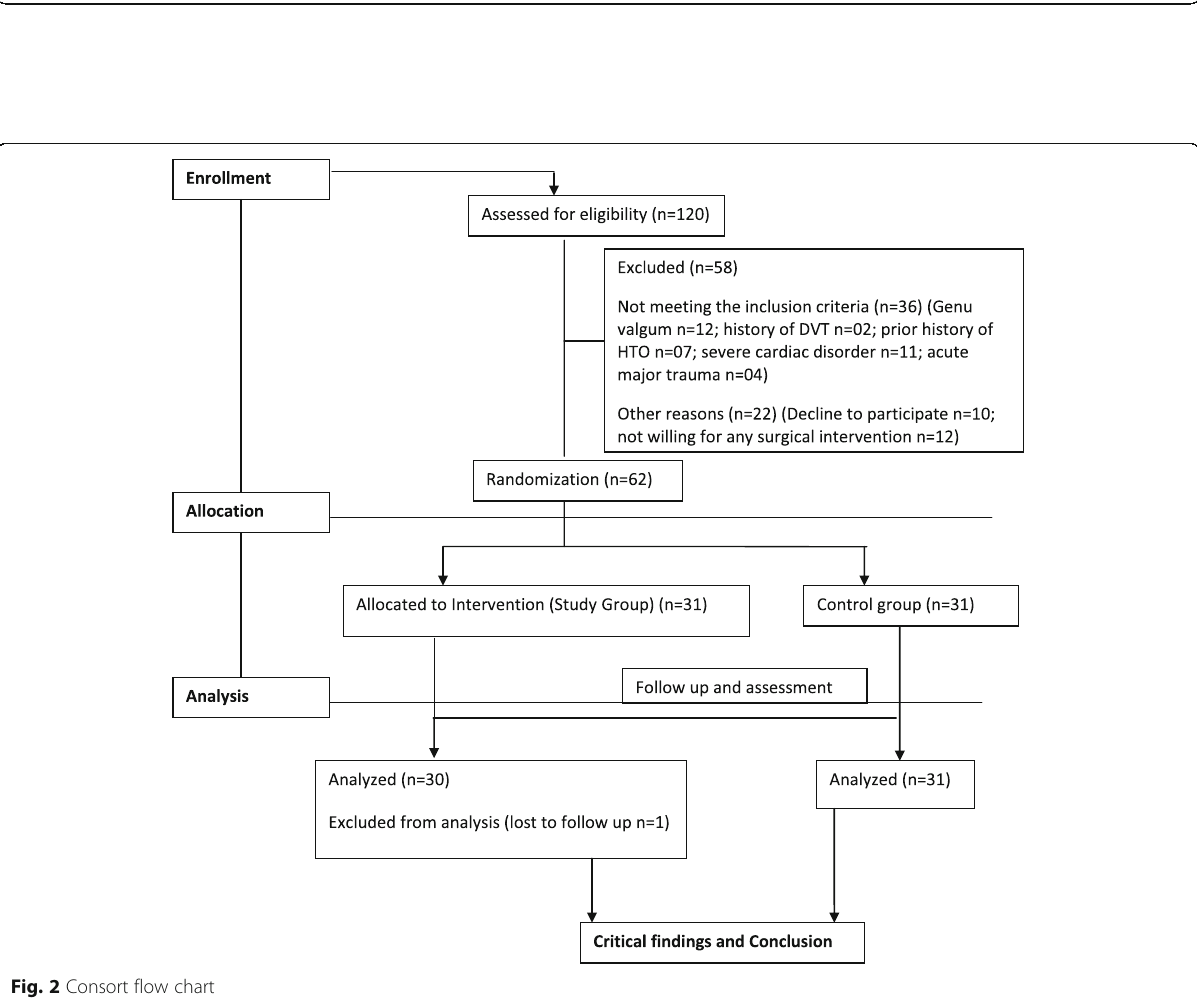
Fig. 1 An anteroposterior X-ray of the knee showing reduction degenerative changes, irregularity, diminution of medial joint space, osteophytes, varus deformity (arrow showing features suggestive of osteoarthritis) with stress fracture of proximal tibia (arrow showing stress